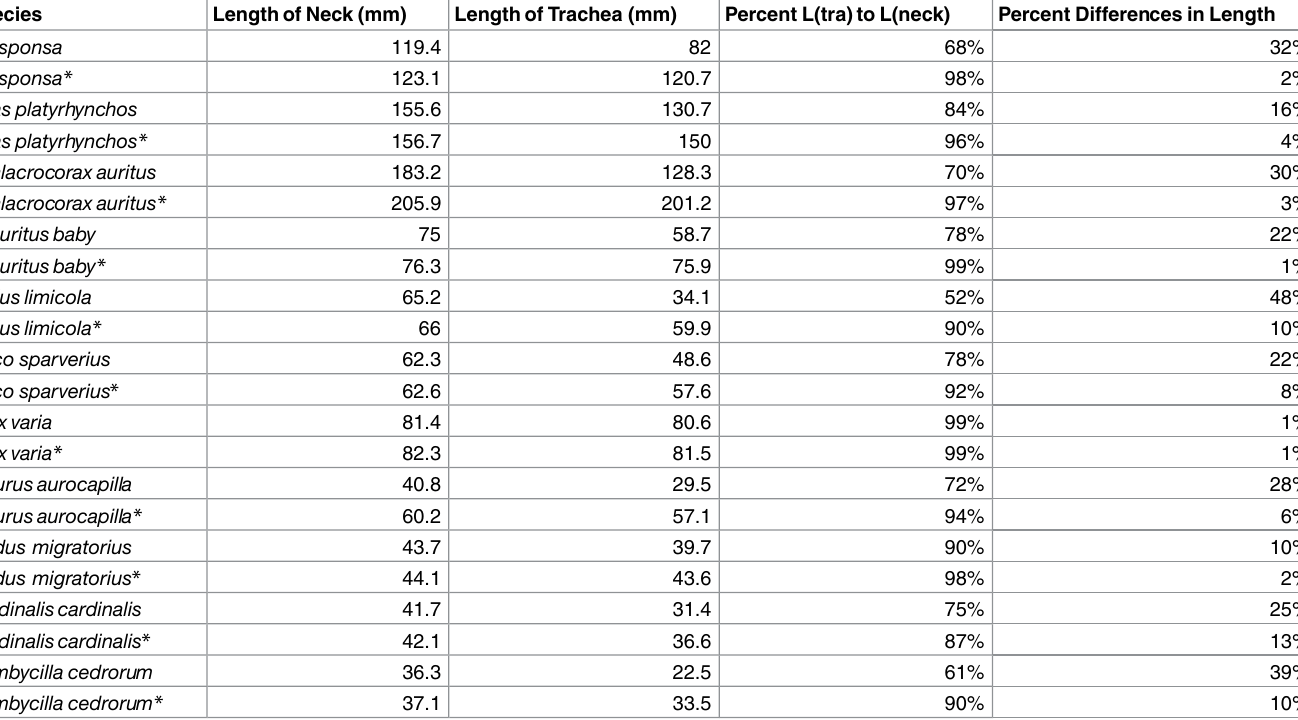
Positions, degree and immediacyof displacement. Birds demonstrate tracheal and esophageal displacement with notably lateralized tracheae and esophagi. Unlike the trachea and esophagus which may shift their positions, the rest of the cervicalviscera do not move to one side or other. Rather, the arteries, veins and nerves occupy their respective sides (i.e., the left external carotid occupies the left side of the neck whereas the right external carotid stays on the right side). Of the 42 species of extant birds dissected/observed/reported in this study, the most ubiquitous pattern seen was right lateralization of the trachea and esophagus together. Two other less common patterns observedwere left lateralization together and separated later- alization (where the trachea lay on one side whereas the esophagus lay on the other side). Addi- tionally, displacement was most commonly seen to be achieved immediately upon leaving the oropharyngeal region. There, they would then remain lateral for the entire length of the neck, Table 3. Differences in Neck and Tracheal Lengthsin